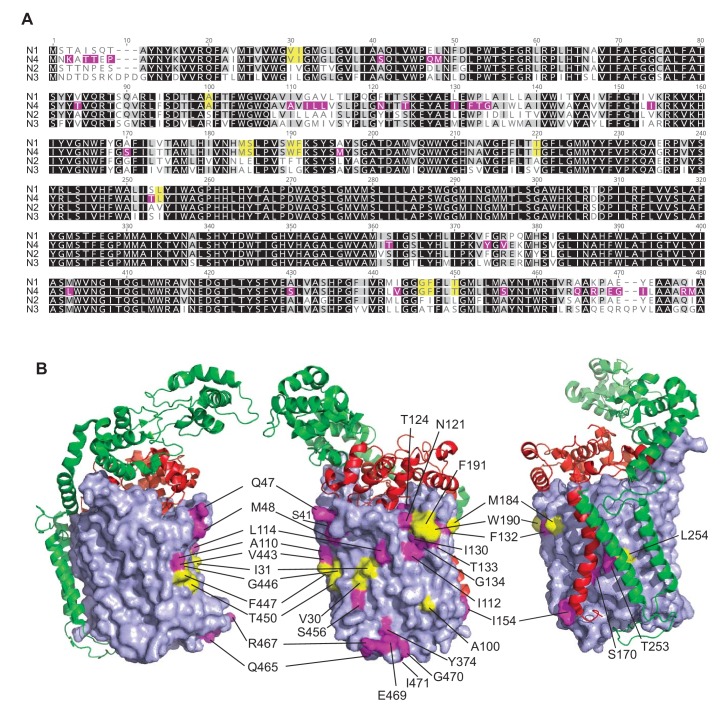
Comparison of the PA14 CcoN subunit sequences and analysis of the predicted structure of CcoN4.(A) Amino acid alignment (ClustalW) of the four CcoN subunits encoded by the PA14 genome. Residues conserved among all four N subunits are highlighted in black; residues conserved among any three of the four N subunits in gray; residues shared exclusively between CcoN1 and CcoN4 in yellow; and residues unique to CcoN4 in purple. (B) Predicted structure of CcoN4 from P. aeruginosa PA14, obtained by threading the PA14 sequence through the reported structure for the CcoN subunit of P. stutzeri (PDB: 5DJQ; Buschmann et al., 2010) using SWISS-MODELL (Biasini et al., 2014). Surface-exposed residues that are shared exclusively between CcoN1 and CcoN4 are shown in yellow, while residues that are unique to CcoN4 are shown in magenta. Ribbon structures of the CcoO and CcoP subunits from P. stutzeri are shown in red and green, respectively. Structures were generated using PyMol (Schrödinger, LLC, 2015).